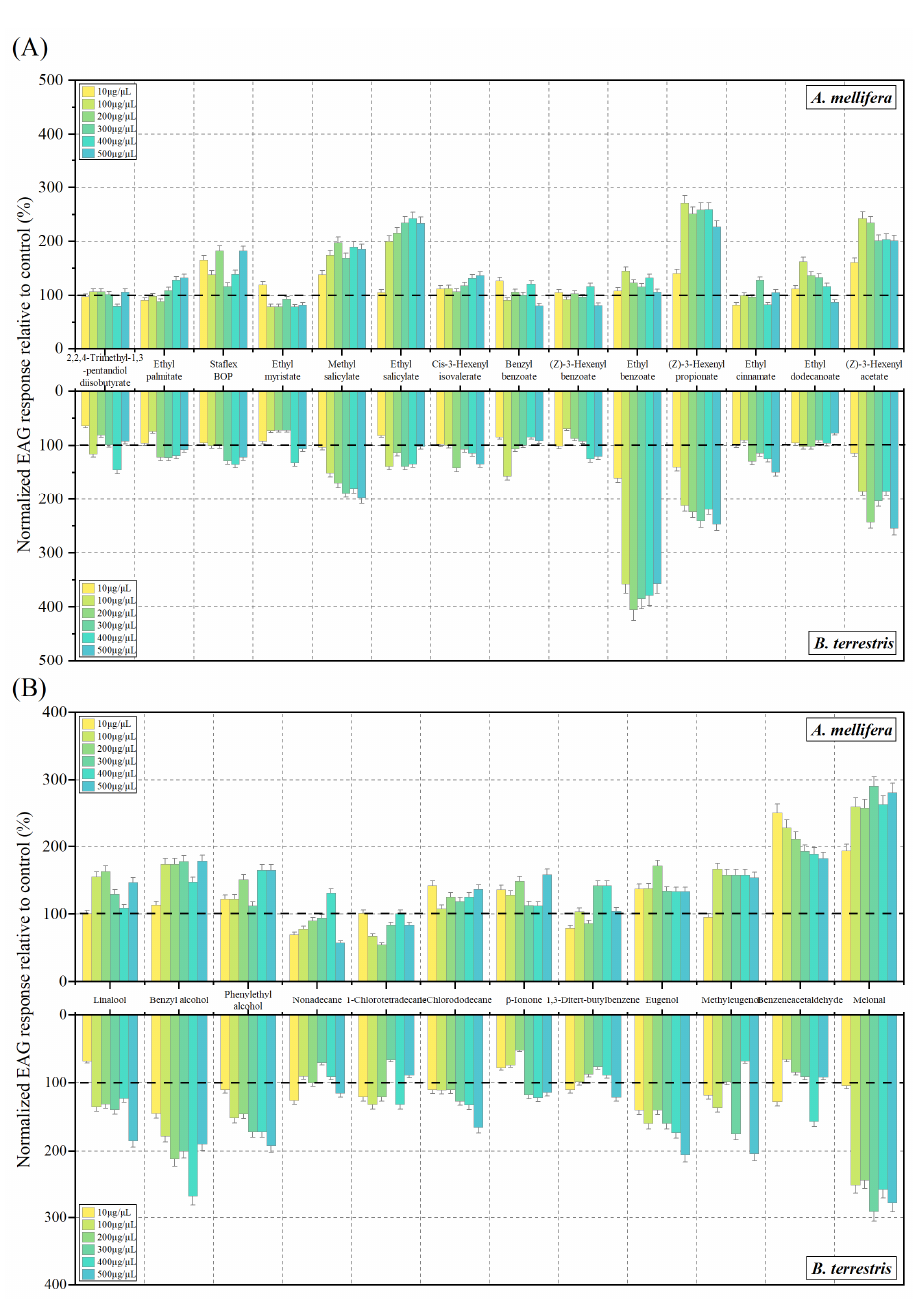
Figure 3. EAG responses of bees to volatile compounds: ( A ) EAG responses of bees to esters relative to liquid paraffin; ( B ) EAG response of bees to other compounds relative to liquid paraffin. The 100% black dotted line represents the EAG response of the control liquid paraffin.